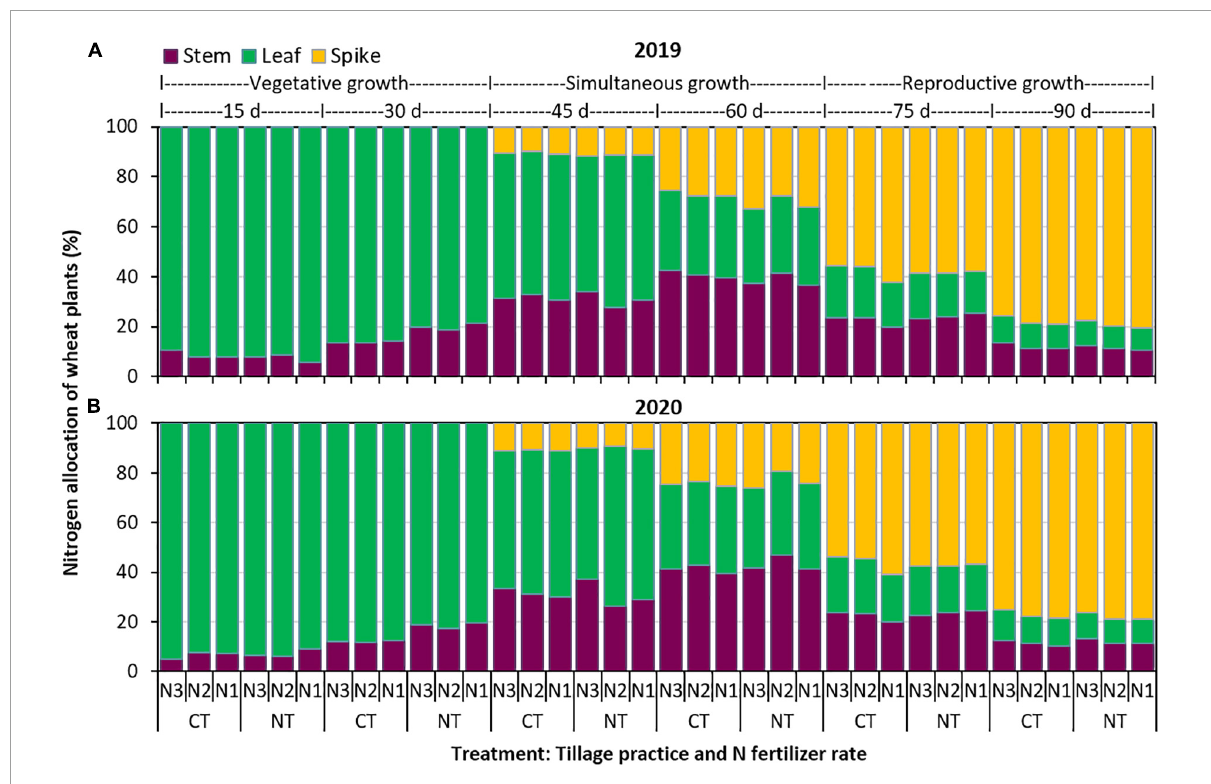
FIGURE3 Nitrogen allocation (NA) in the stem, leaf, and spike of wheat plants with two tillage practices and three N fertilizer rates in (A) 2019 and (B) 2020. CT and NT represent conventional tillage without plastic film mulching and no-till with previous plastic film mulching. N1, N2, and N3 represent N fertilizer applied at 135, 180, and 225 kg N ha - 1 , respectively.